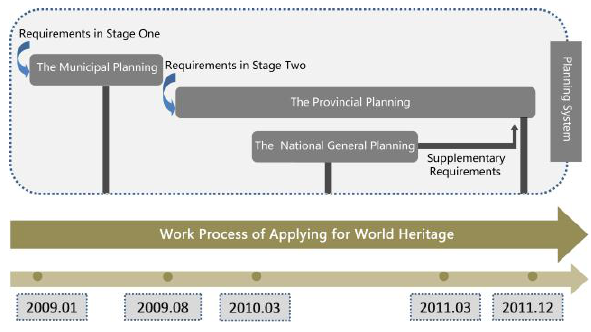
Figure 1. Planning system